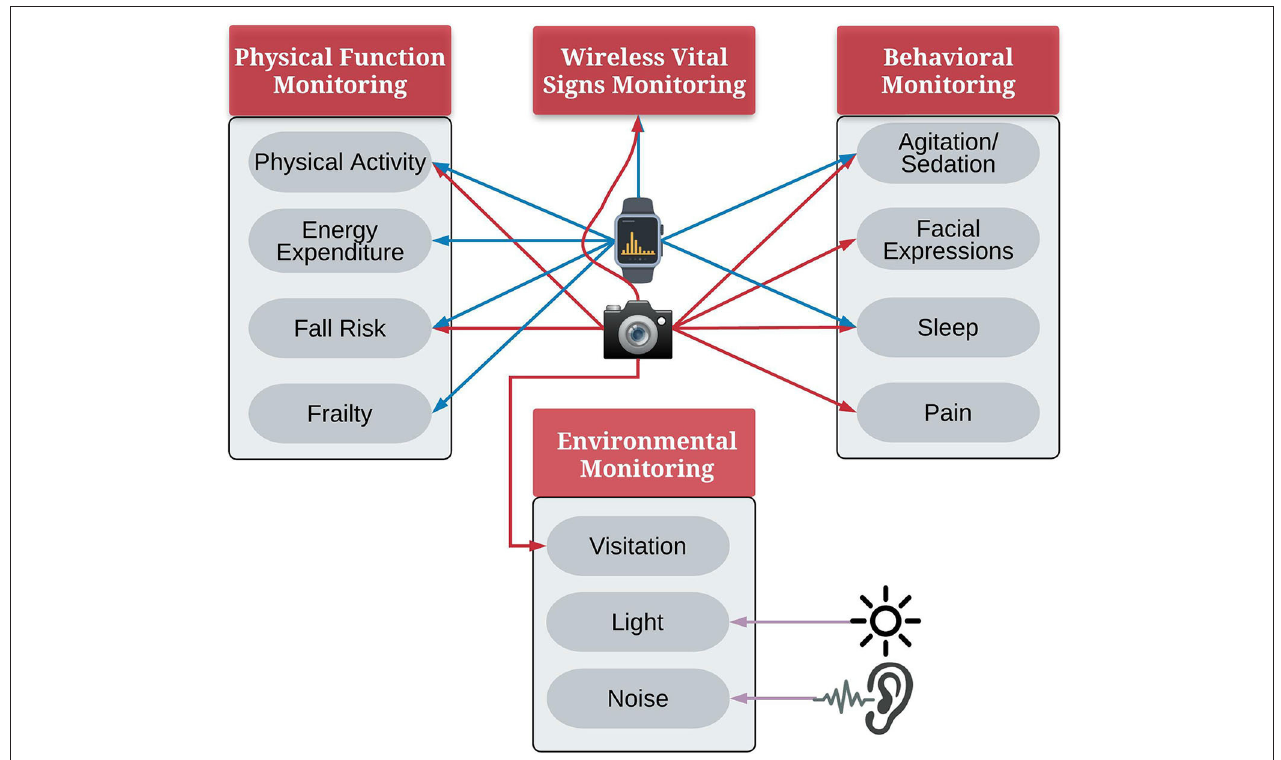
FIGURE 1 | Applications of pervasive sensing for monitoring ICU patients, iconfinder.com.